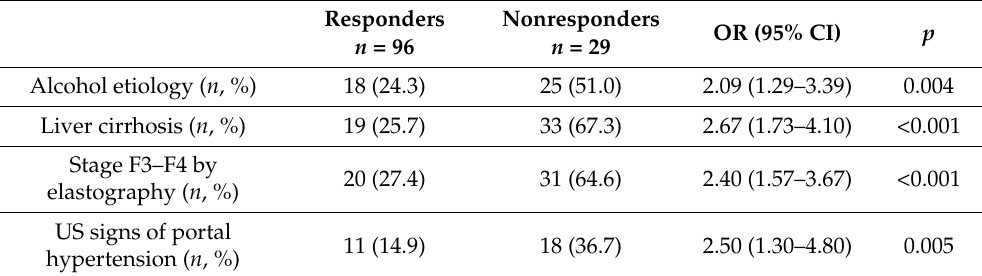
Table 4. Comparison of patient characteristics between responders and nonresponders to HBV vaccination by univariate analysis at twelve